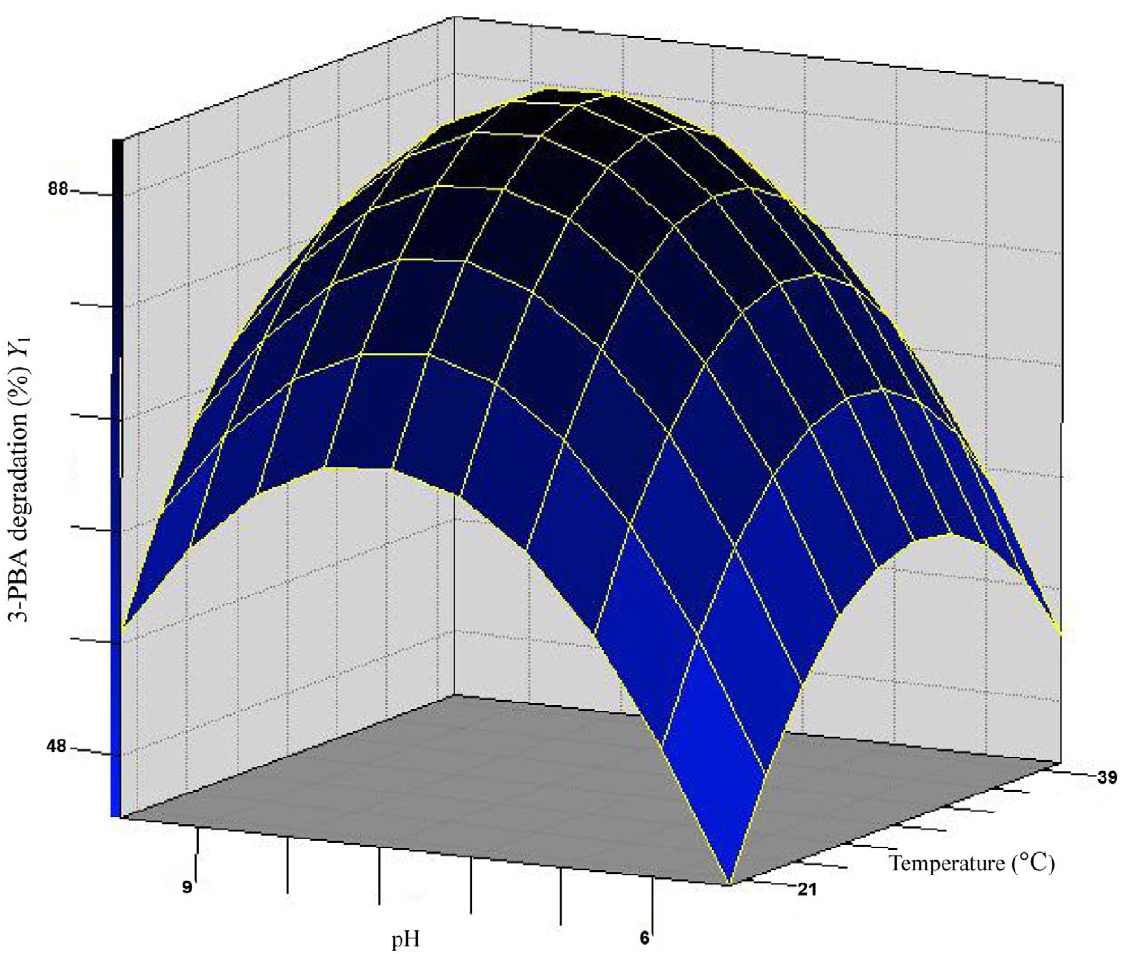
Figure 3. Response surface plot showing the effects of temperature and pH on 3-PBA degradation by strain DG-02 with inoculum at OD 600 =0.6.